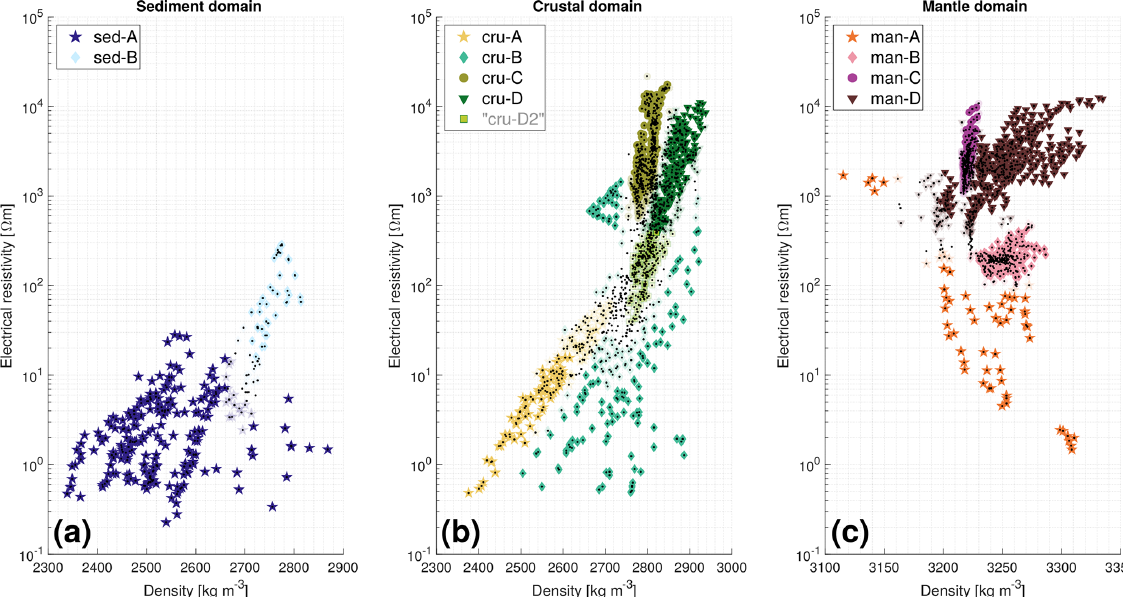
Figure 3. Cross-plots of electrical resistivity and density and their identified clusters. Colour saturation of symbols represents the posterior probability within Gaussian mixture model: full saturation of symbols indicates a certainty above 90%; transparent symbols indicate a certainty between 60% and 90%; dots without colour saturation indicate a certainty below 60%. (a) Sediment domain (depth extent defined by seismic models of Fromm et al., 2017a, and Planert et al., 2017). (b) Crustal domain (depth extent defined as sediment basement to Moho derived from Laske et al., 2013, and Maystrenko et al., 2013). Cluster cru-D2 is manually defined by dividing the identified cluster cru-D horizontally at 400 (cid:127) m. (c) Mantle domain (below